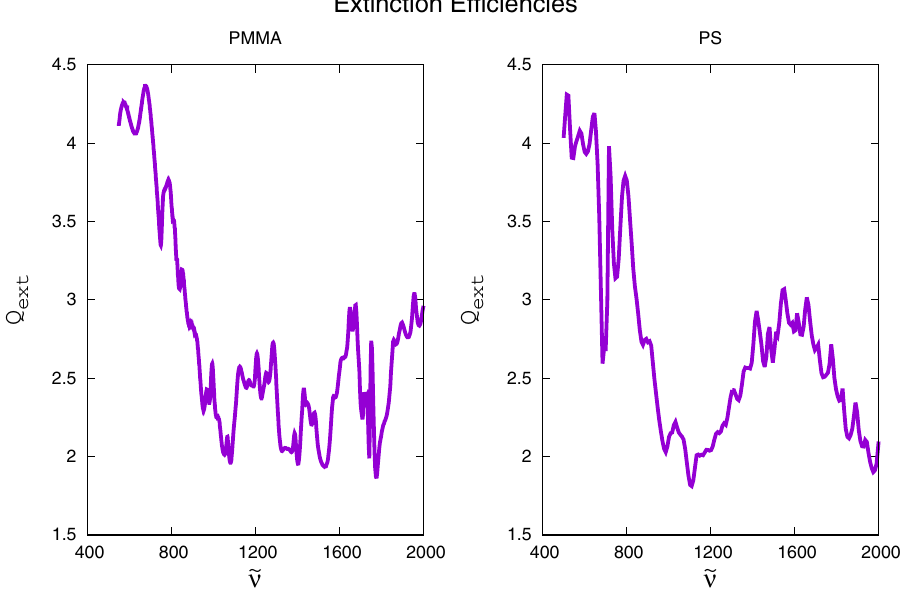
Figure 1. Extinction efficiency Q ext ( ˜ ν) , numerically computed 16 on the basis of published refractive-index data 14,15 for a sphere of radius 10 µ m, homogeneously filled with PMMA (left panel) and PS (right